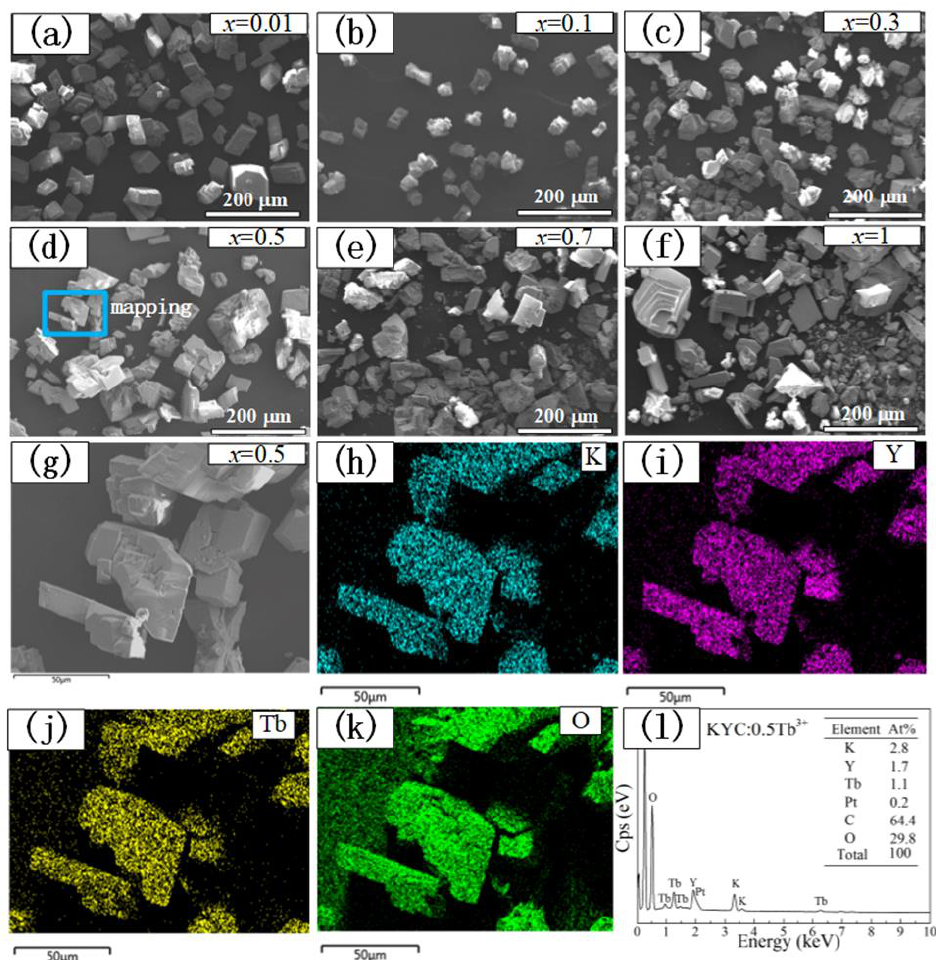
Figure 2. ( a – f ) Morphologies of KYC:xTb 3+ ( x = 0.01, 0.1, 0.3, 0.5, 0.7, 1); ( g ) Selected area of KYC:0.5Tb 3+ ; ( h – k ) Element mapping of K, Y, Tb, and O; ( l ) Energy dispersive spectroscopy analysis .